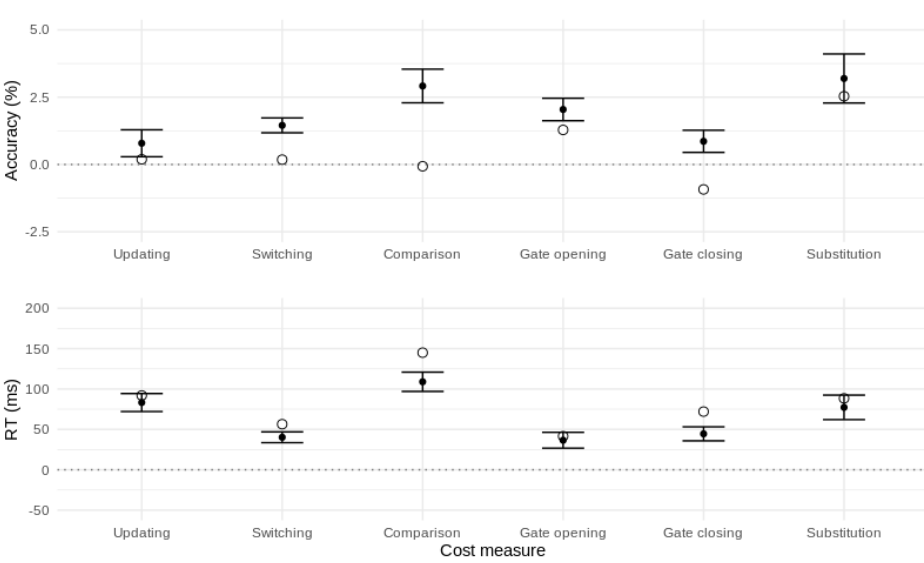
Figure 6. Fits of top model to reference-back cost effects. Unfilled circles represent data effects. Filled circles represent posterior model predictions with 95% credible intervals.